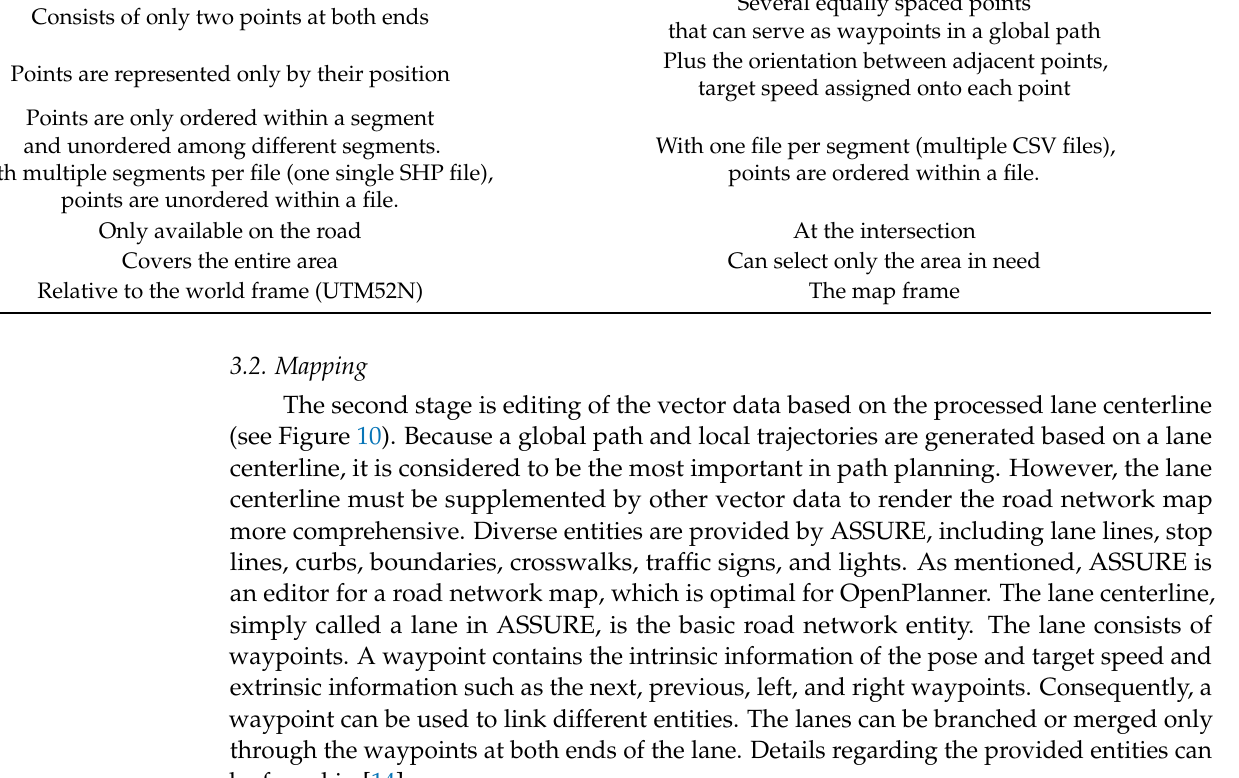
Table 12. Requirements for using A2_Link as source data of a global path in OpenPlanner.